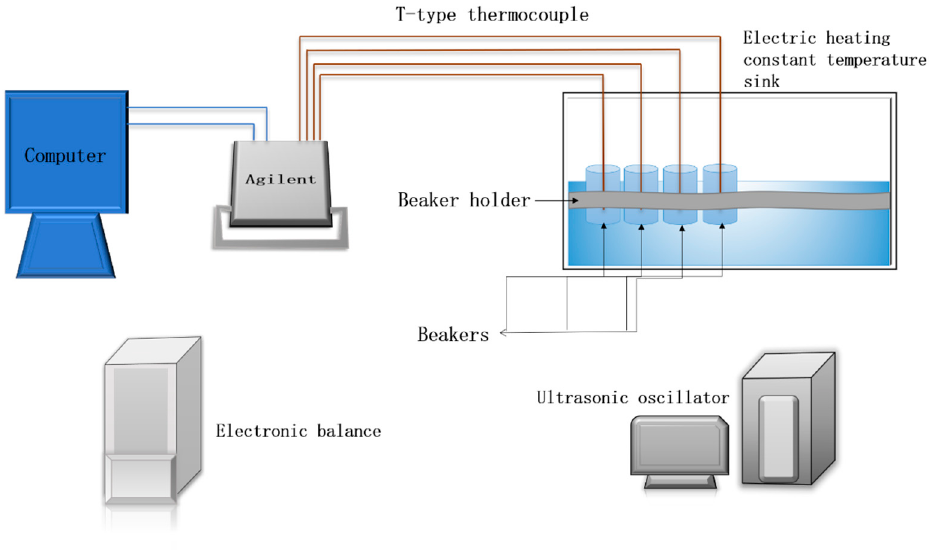
Figure 1. Experimental platform system.